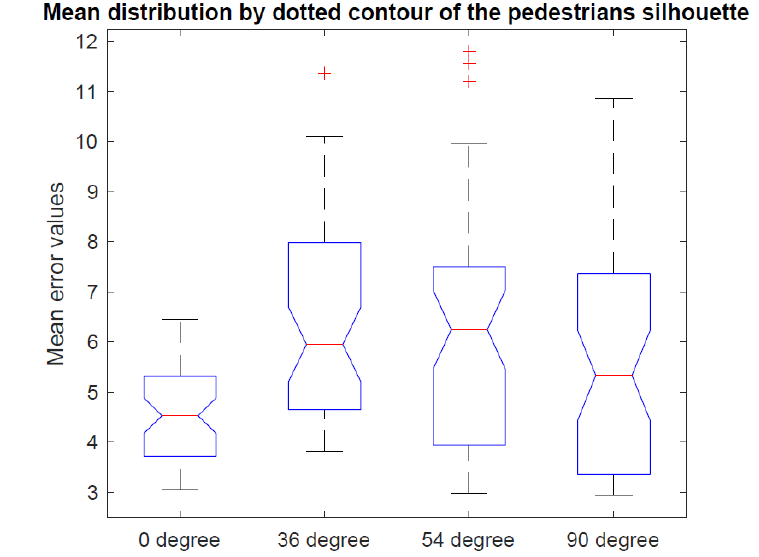
Figure 13. Mean fit error between landmarks and the estimated contour for the CASIA Gait collection when the pedestrian walks at 0, 36, 54, or 90 degrees, relative to the